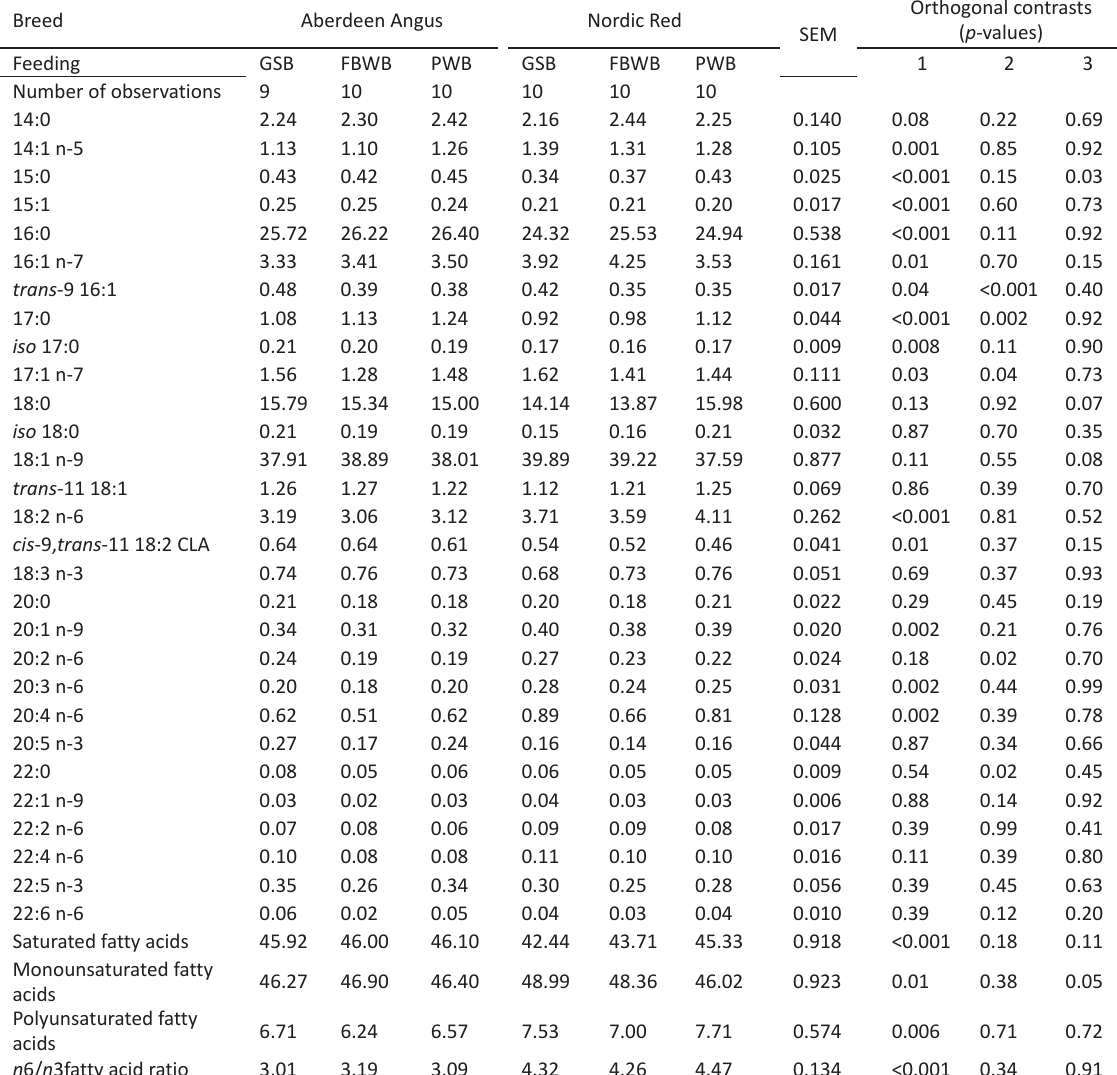
Orthogonal contrasts ( p -values) SEM